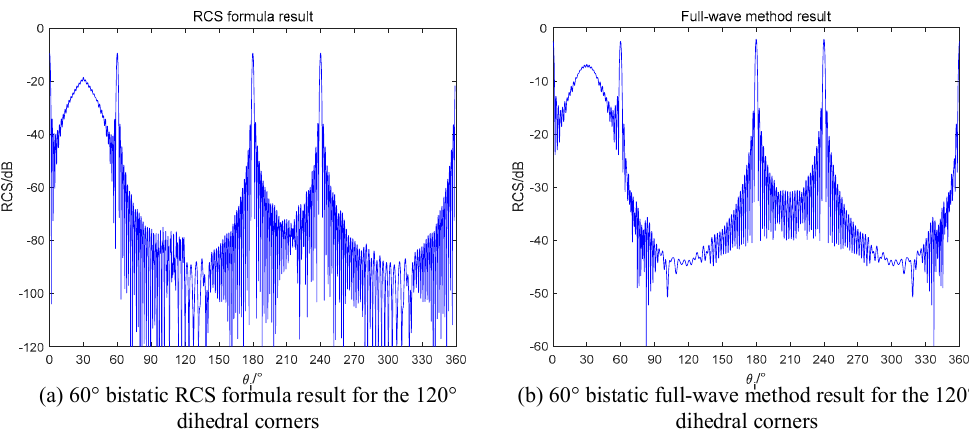
Figure 14. 60° bistatic RCS of the 120° dihedral ( a ) RCS formula in this paper; ( b ) Full-wave method. Figure 14. 60 ◦ bistatic RCS of the 120 ◦ dihedral ( a ) RCS formula in this paper; ( b ) Full-wave method.